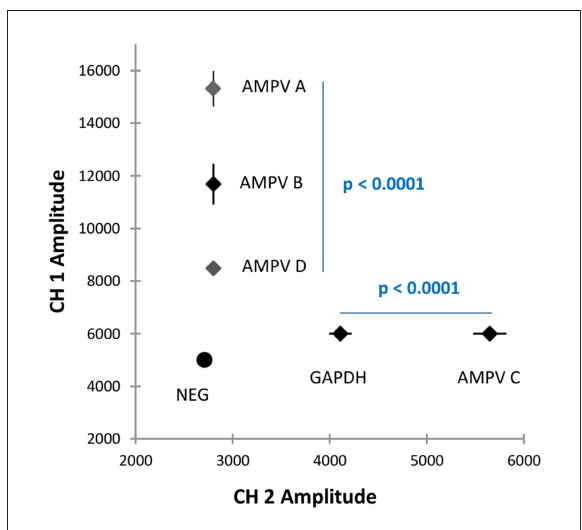
FIGURE1 Graphical 2D plot of the five-plex RT-ddPCR showing different clusters for each AMPV subgroup, each AMPV subgroup plus GAPDH and the negative